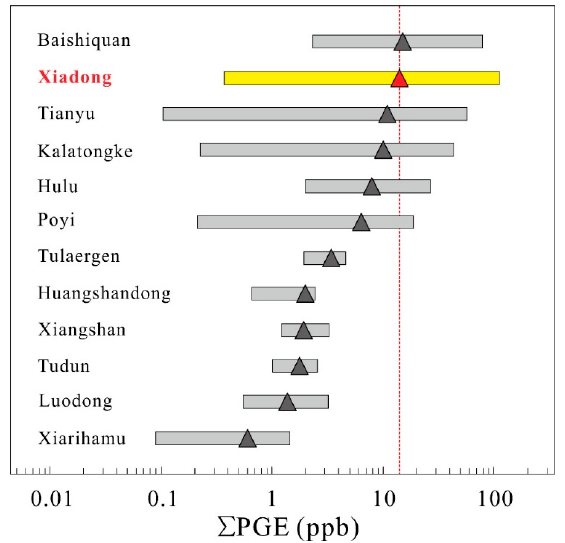
Figure 9. Comparisons of PGE concentrations in the Xiadong Alaskan-type complex and other mafic– ultramafic complexes in the southern Central Asian Orogenic belt (CAOB). Data were taken from References [55–64]. The triangle indicates the